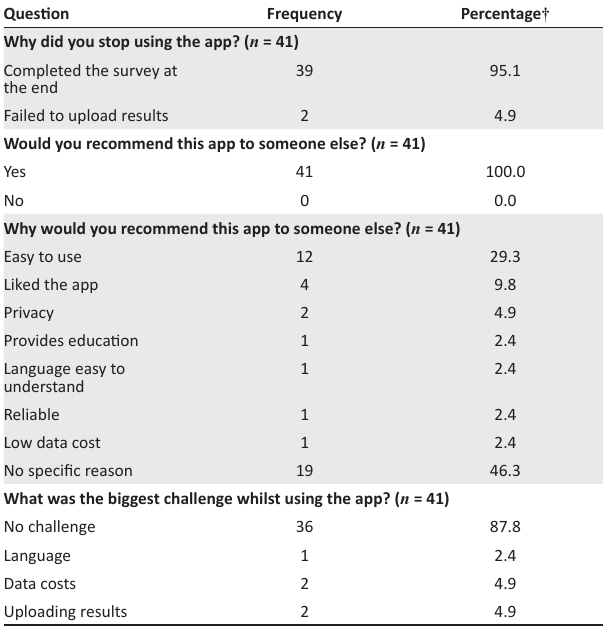
TABLE 3: Open-ended user experience questions.